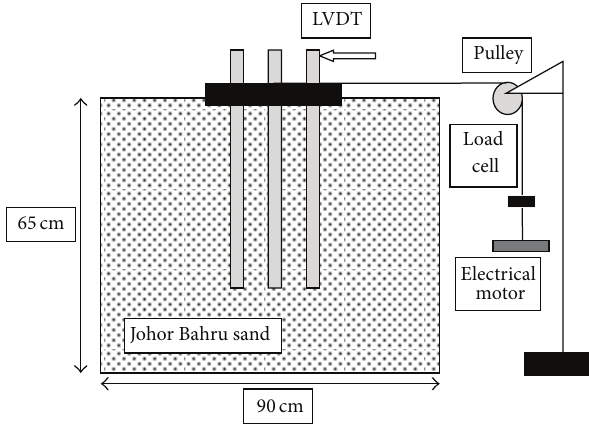
Figure 1: Side view of experimental